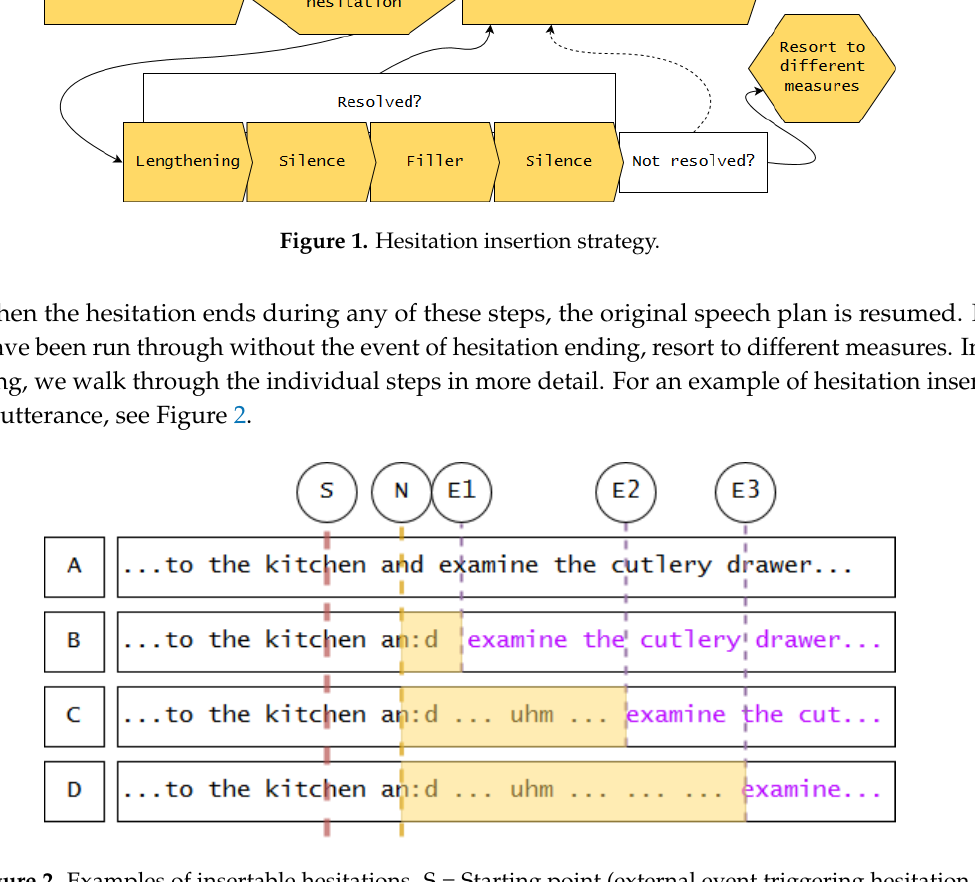
Figure 2. Examples of insertable hesitations. S = Starting point (external event triggering